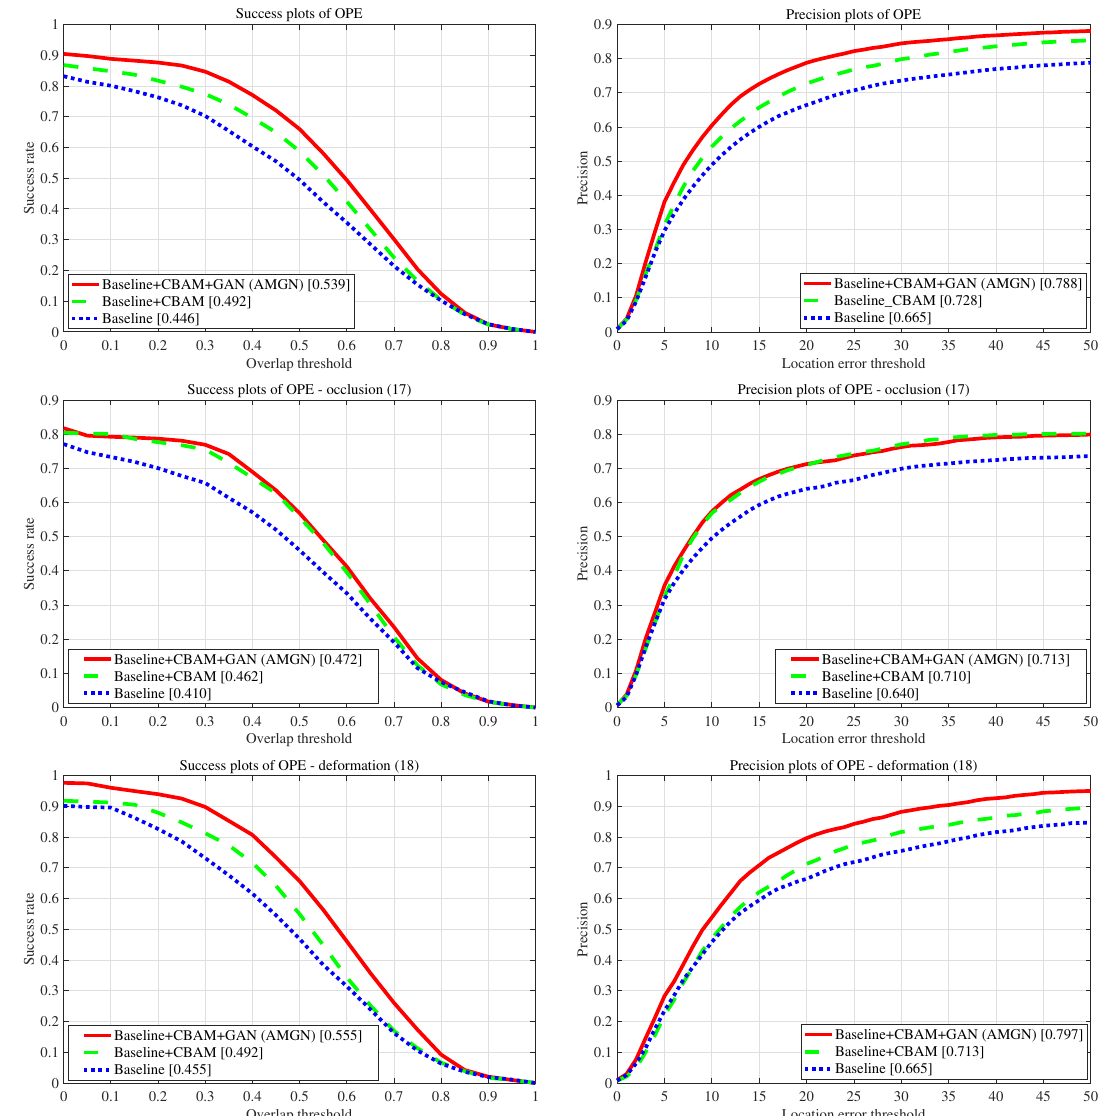
Figure 11. Ablation studies results on attention module and adversarial learning on the DTB70